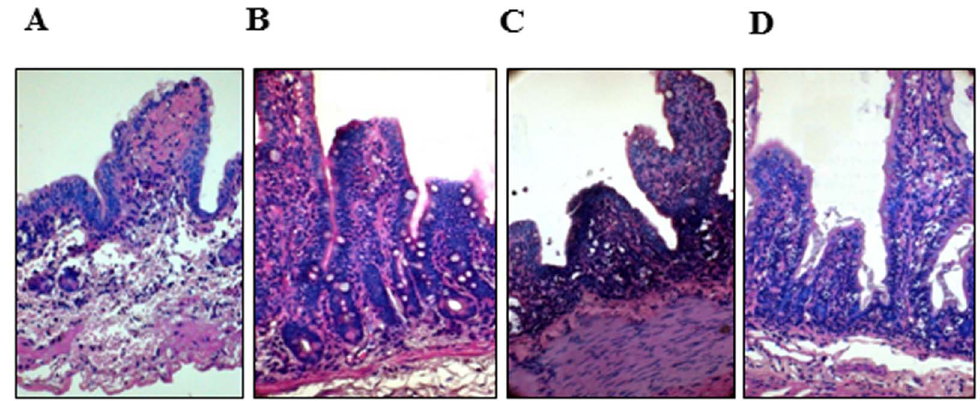
Figure 7. Histological study of rabbit ileal tissues. Panels show photomicrographs of histology of rabbit ileal loop tissue after infection with A . wild type V. cholerae showing hemorrhagic fluid accumulation (Fig. 5B). Extensive damage of mucosa with damage to the villus structure and gross dilatation of villi with hemorrhage and necrotic changes in villus, lamina, propria, mucosa and sub-mucosal area was observed. B . Almost normal villous and mucosal structure was observed in ileal tissues infected with D chiA2 mutant though some congestion and scattered hemorrhagic change was noticed in villus, lamina, propria and rest of the mucosa. C . complemented strain showing hemorrhagic fluid accumulation. Extensive damage of mucosa with damage to the villus structure and gross dilatation of villi with hemorrhage and necrotic changes in villus, lamina, propria, mucosa and sub-mucosal area was observed. D . PBS treated ileal tissue showed normal gut mucosa.